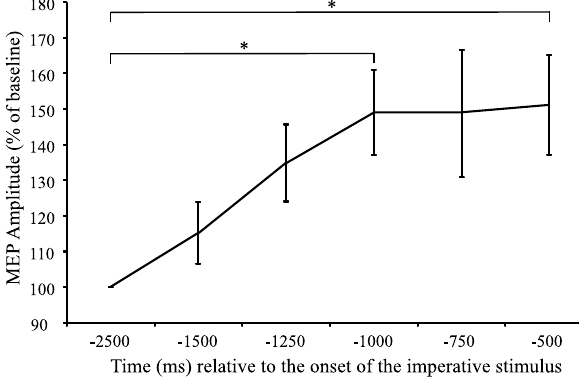
Figure 3. Mean ( + / 2 SE) motor-evoked potential (MEP) amplitude expressed as a percentage of baseline for the time encompassing 2 2500 ms to 2 500 ms relative to the onset of the imperative stimulus. Asterisks (*) denote a significant increase in MEP amplitude during this preparation phase compared to baseline.